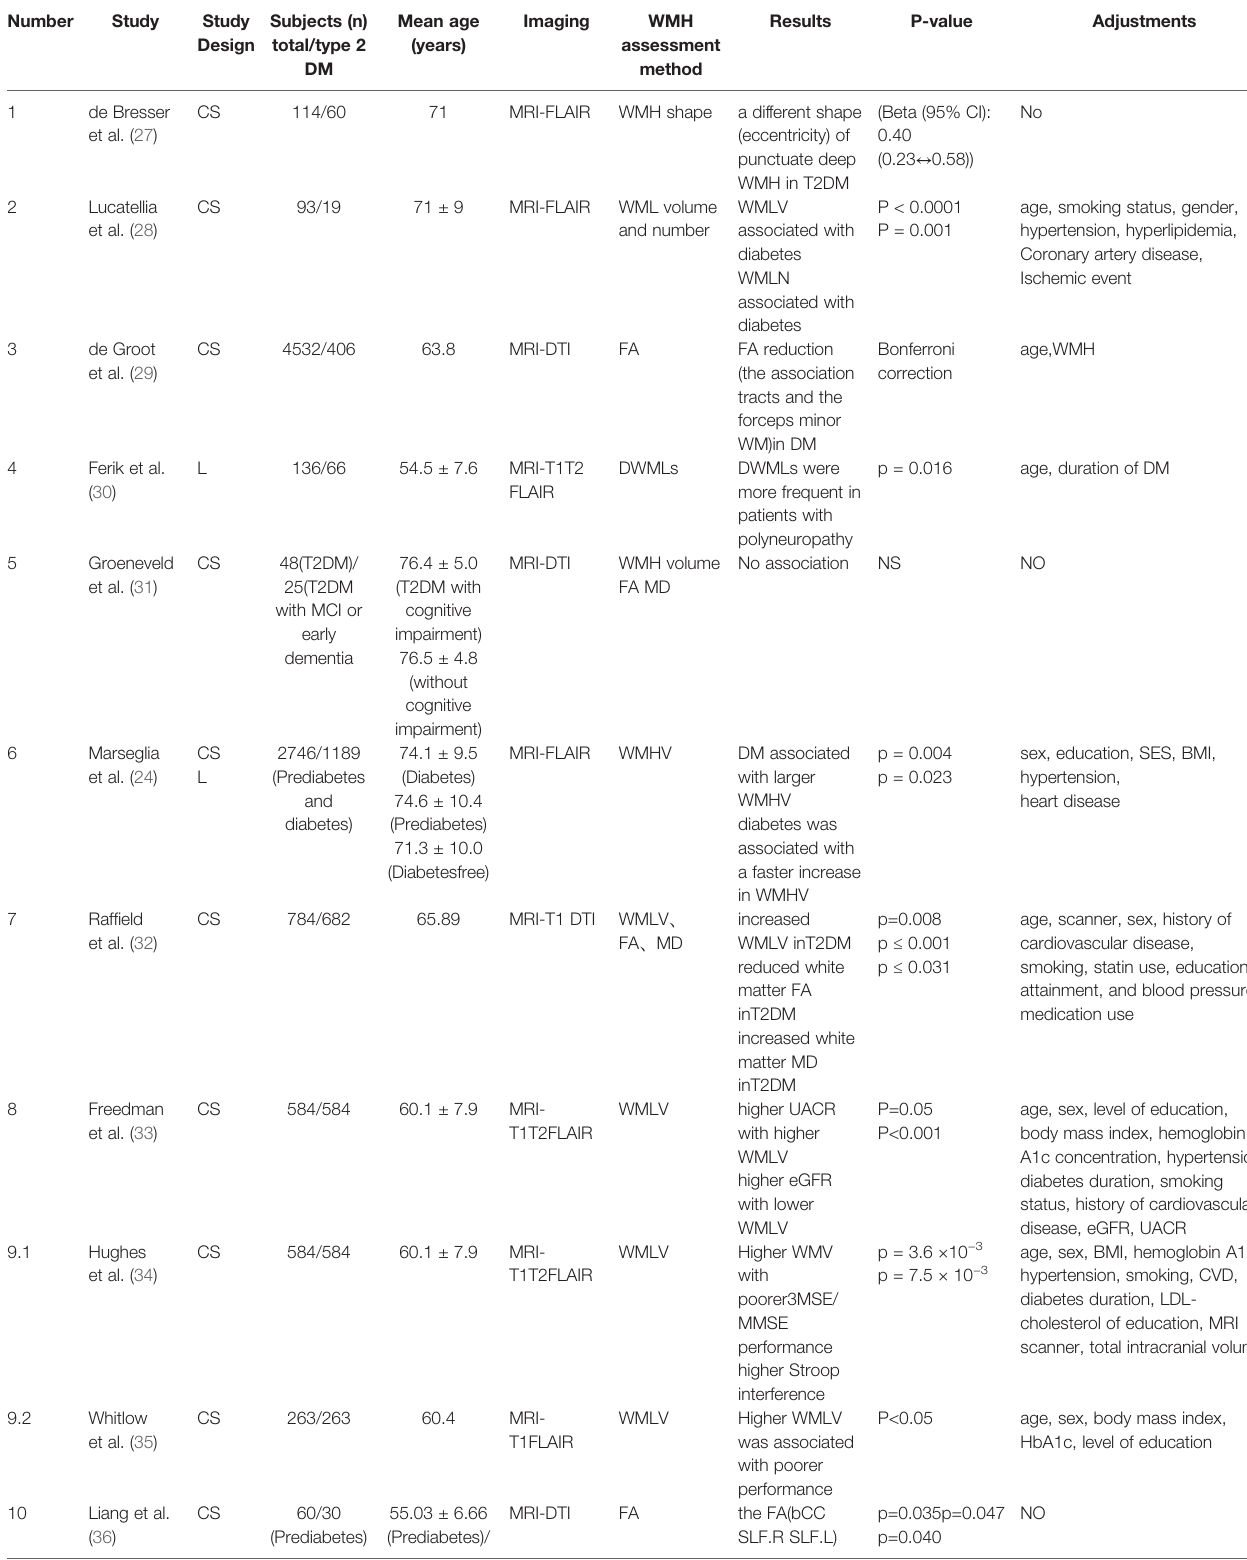
TABLE 1 | The study design, sample size, mean age, neuroimaging methods, study results, and correction parameters in the included